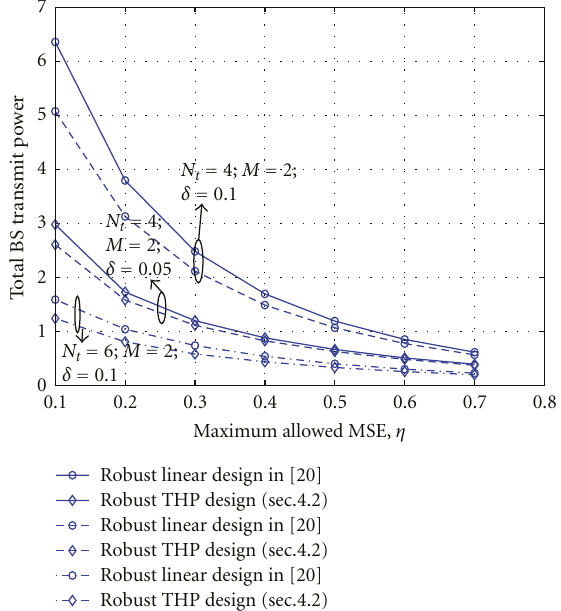
Figure 5: Total BS transmit power ( P T = (cid:3) B (cid:3) 2 F ) required as a function of maximum allowed MSE at the user terminals ( η 1 = η = η ) in the proposed robust design in Section 4.2 for the NBE 2 model. N t = 4,6, M = 2, N r uncertainty range δ 1 = δ 2 = δ = 0 . 05,0 . 1. Proposed robust THP transceiver design in Section 4.2 requires lesser BS transmit power to meet the MSE constraints at the user terminals than the robust linear transceiver design in